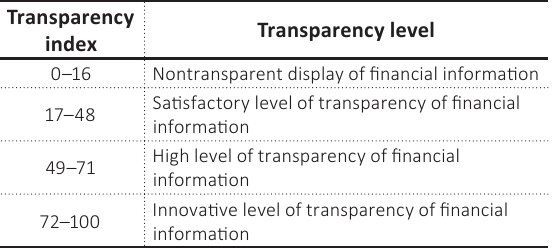
Table 3. Universities’ transparency scale